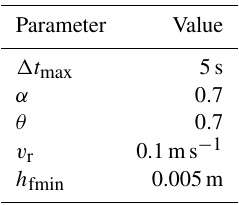
Figure 4. Comparing Itzï with an analytic solution (the case of the one-dimensional MacDonald long channel with rain).